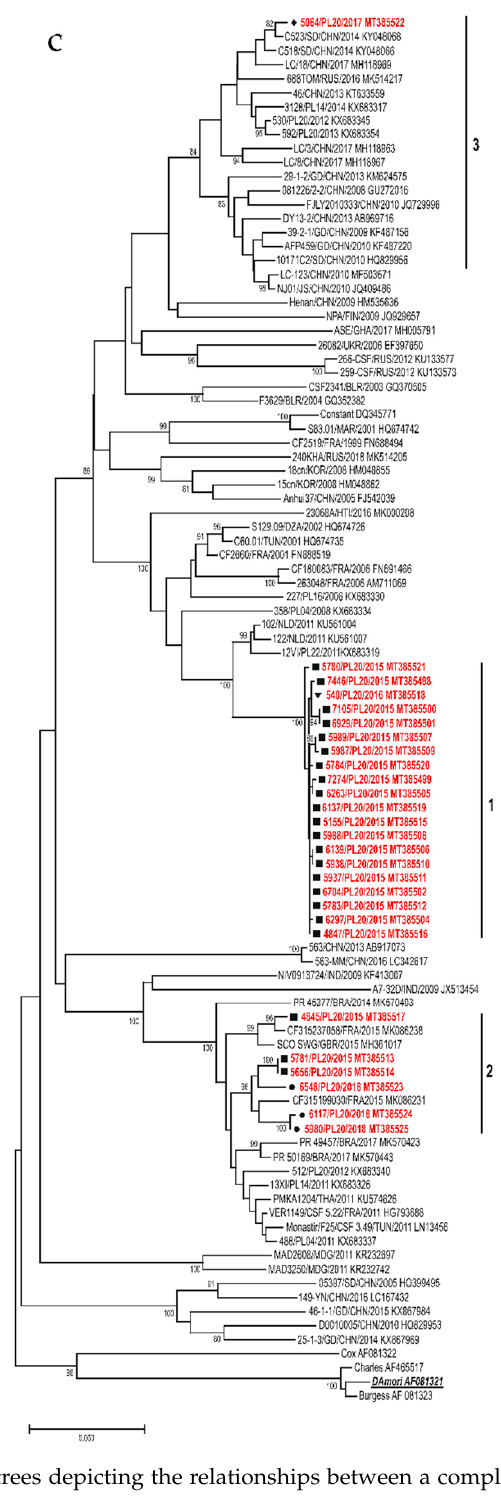
Figure 4. Phylogenetic trees depicting the relationships between a complete VP1 coding region of Polish E30 ( a ), CVB5 ( b ), and E6 strains ( c ) isolated from 2015 to 2019 and sequences from the GenBank. Each strain is referenced by its geographical origin and its accession number. The tree was constructed by the neighbor-joining method and evaluated with 1000 bootstrap pseudoreplicates. Only bootstrap values ≥ 80% are indicated. In the analyses, genetic distances were calculated with Kimura 2-parameter algorithm. Analyses were conducted in MEGA 10.0.5.